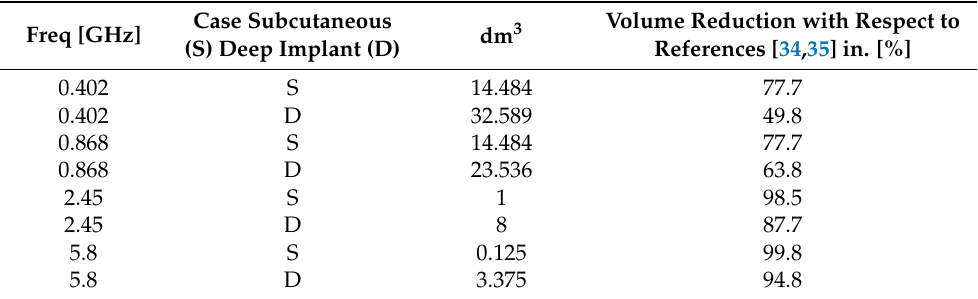
Table 3. Volume needed for the phantom for each case and reduction respect to whole body reference. Subcutaneous (S), Deep implant (D).